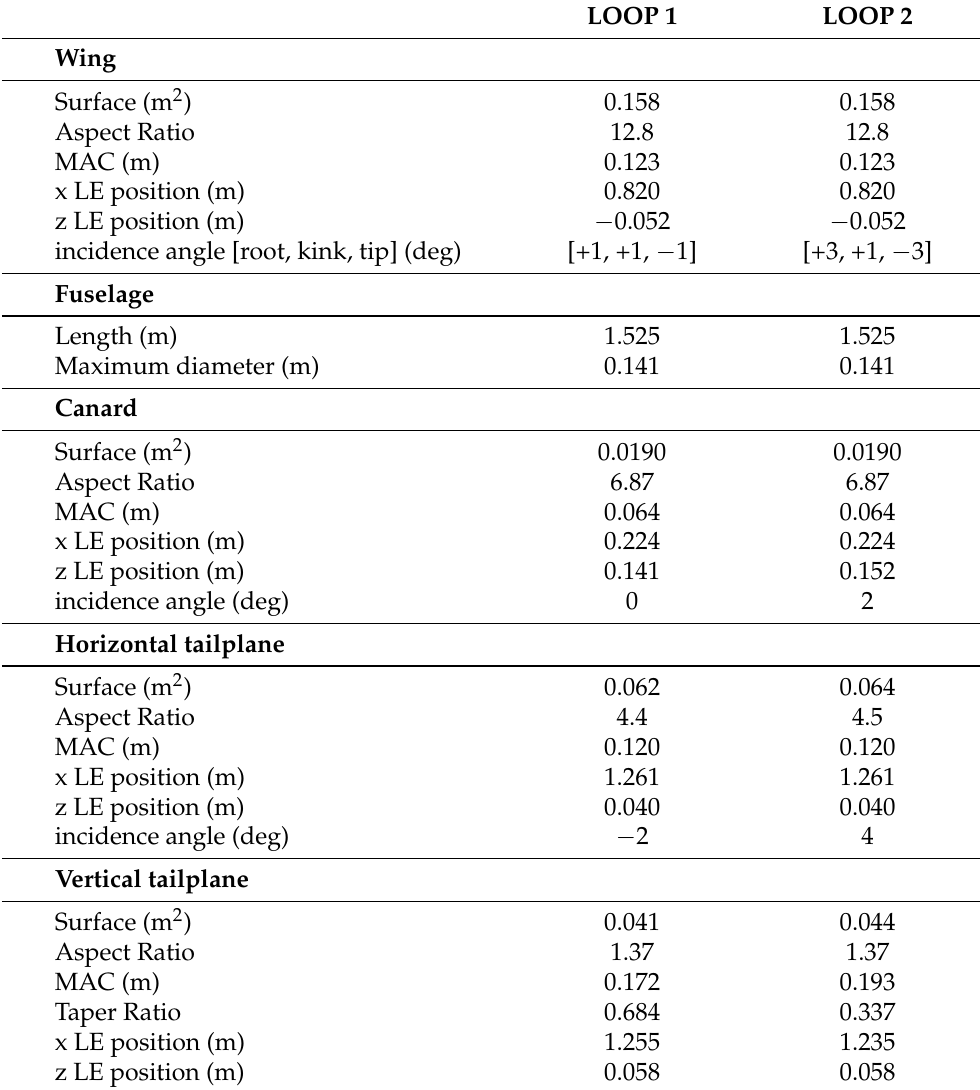
Table 5. Summary of the main geometric